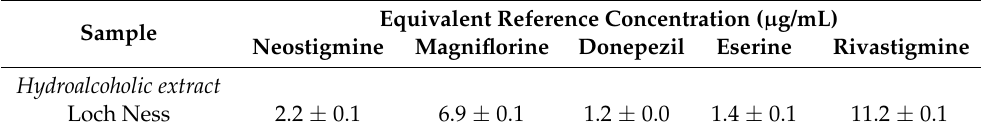
Table 5. Effect on BChE activity.